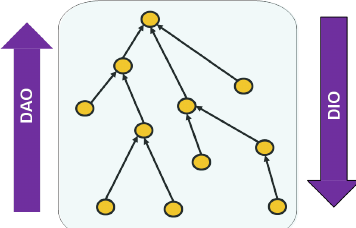
Figure 1. An example of RPL built routing topology (Destination Oriented Directed Acyclic Graph